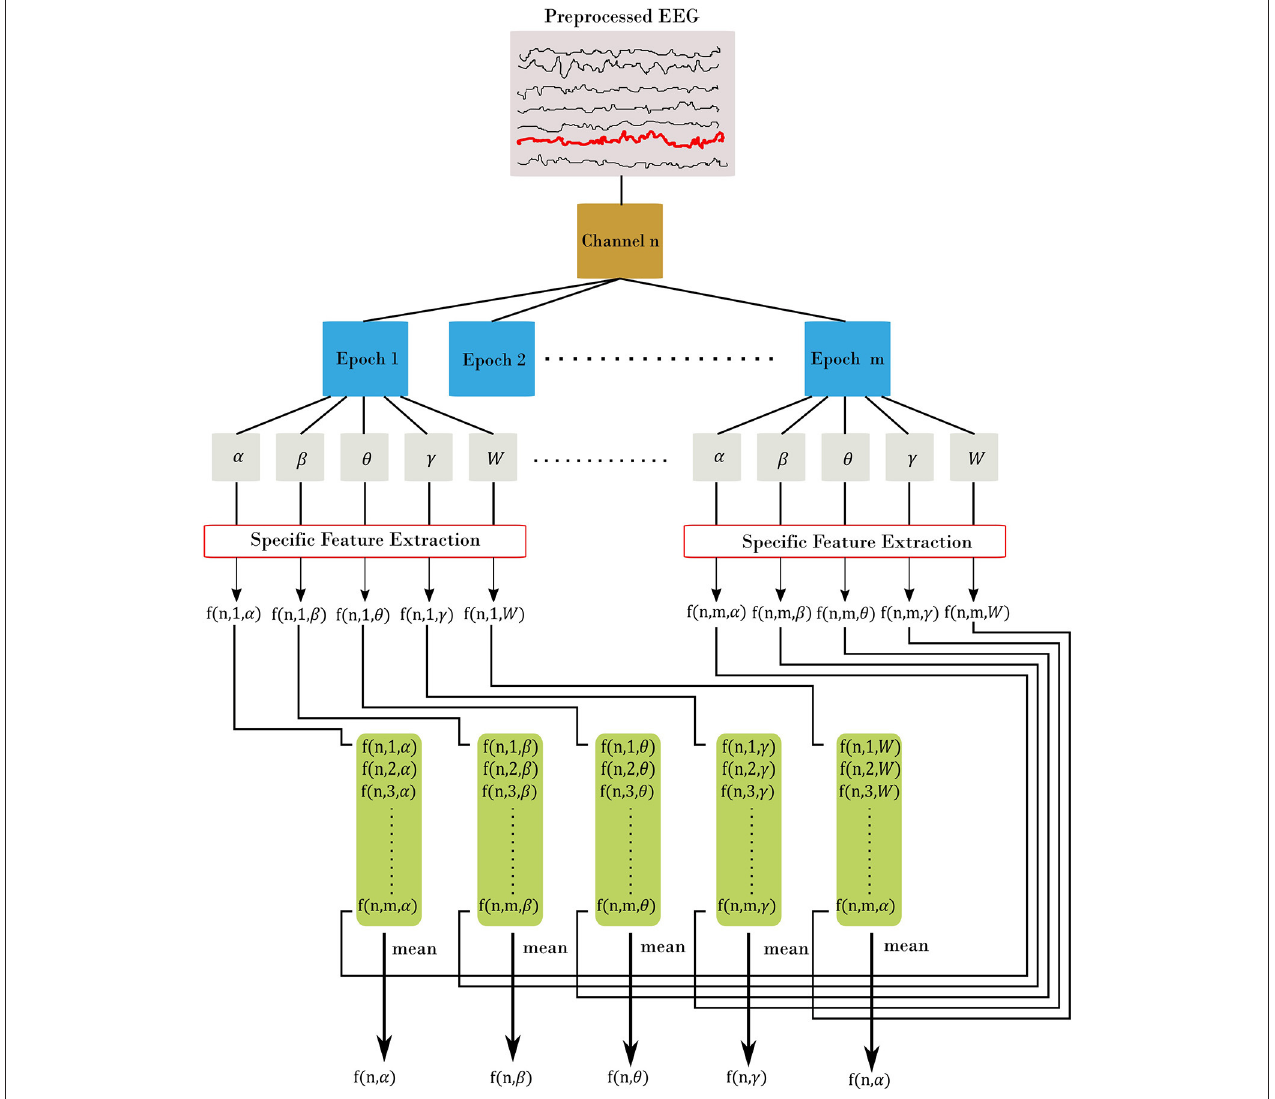
FIGURE 1 | Feature extraction procedure. Each channel is divided into m epoch. From there, we filtered each epoch into α , β , θ , γ , and W frequency bands. Then, for each filtered epoch, we applied the desired feature. This resulted in m feature value from all epochs, which are then averaged to estimate the channel-level feature. In the figure, we represent each feature using three indices: f(channel, epoch, band) with channel = [1..N], epoch = [1..m], and band = [ α , β , θ , γ , W]. The final out is a channel-level feature and represented with two indices f(channel,